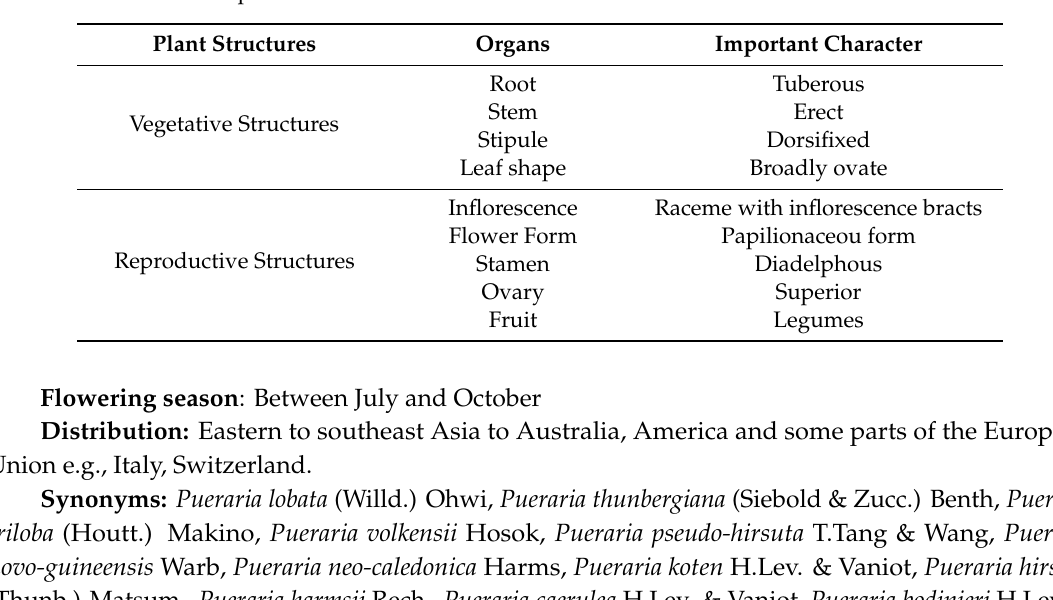
Figure 1. Pueraria montana var. lobata (Willd.) Sanjappa & Pradeep: ( A ) habitat; ( B ) inflorescence and flower. The photo in Figure 1 was taken by D.T. in September 2016 in Japan. Table 1. The important characters of P. montana var. lobata that can be used for